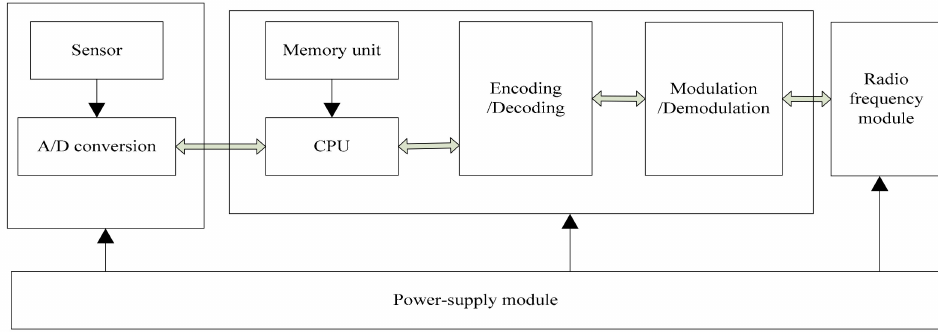
Figure 1. Node structure of wireless